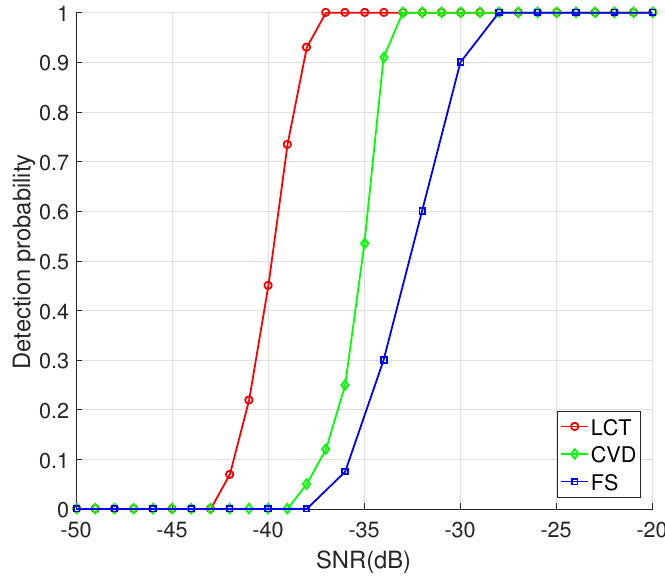
Figure 14. Sensing performance with different